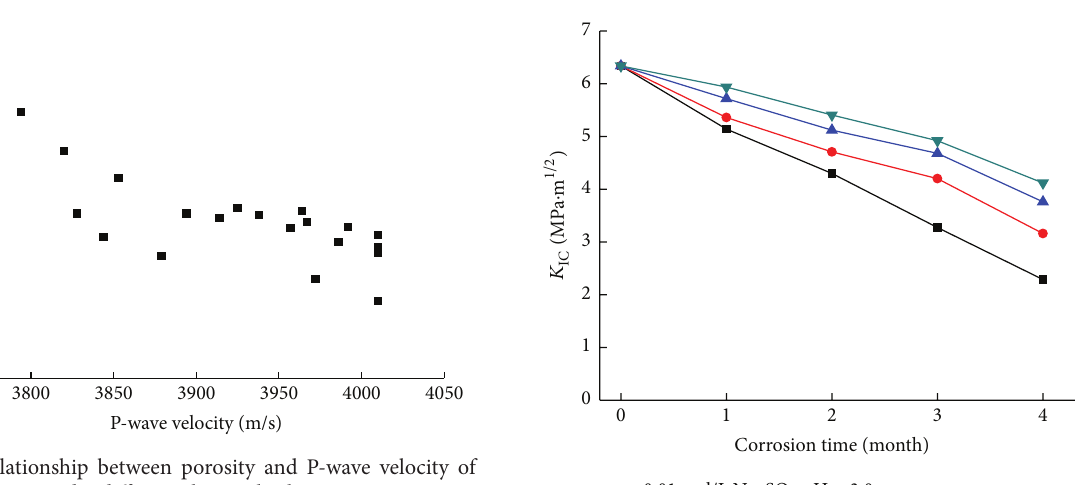
Figure 3: Relationships between porosity, P-wave velocity of granite specimens, and corrosion time under different chemical solutions.